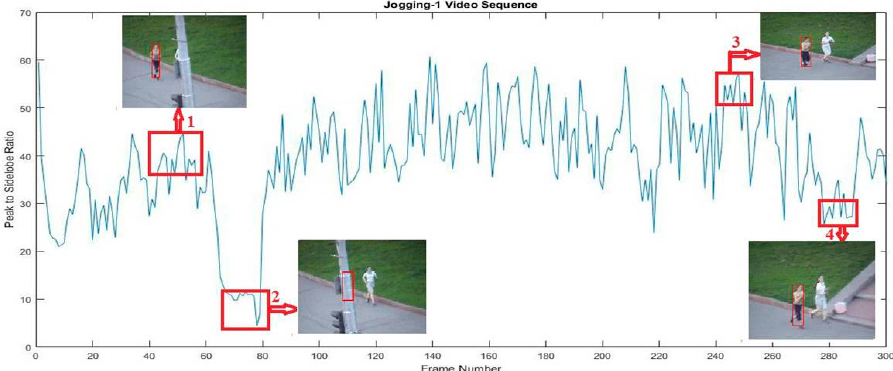
Figure 2. PSR curve analysis using Jogging-1 sequence.